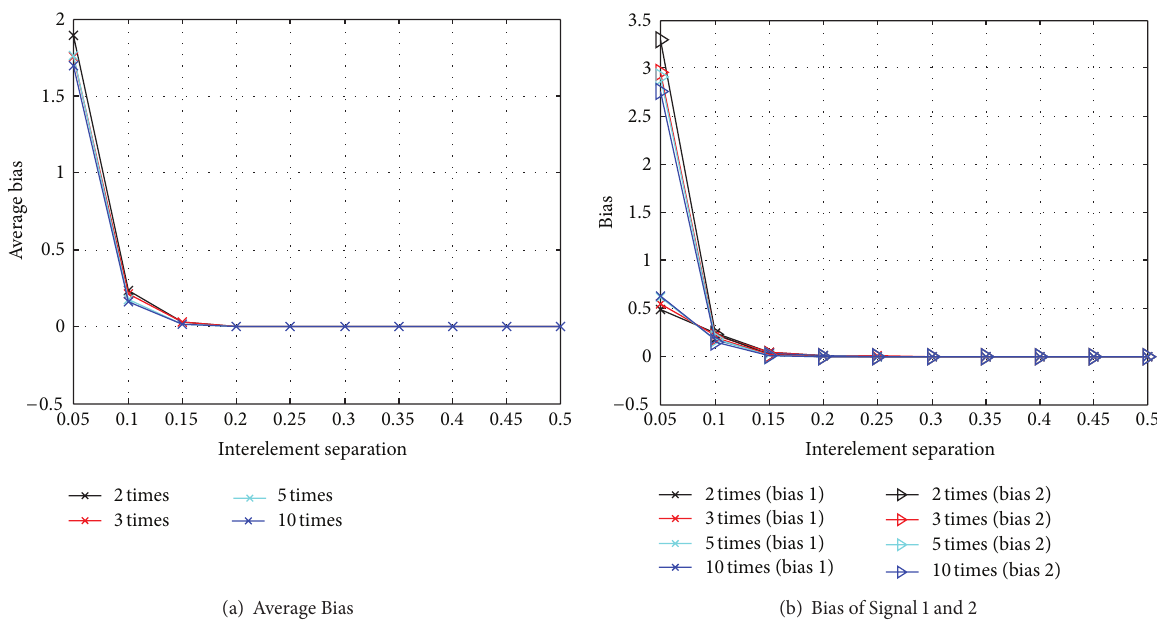
Figure 2: Summary of DOA estimations using MPM for a four-element ULA with interelement separation varying from 0.05𝜆 to 0.5𝜆 . The two incoming signals are from the directions of 𝜙 1 = 5 ∘ (𝐴 1 = 1 , 𝛾 1 = 90 ∘ ) and 𝜙 2 = 6 ∘ (𝐴 2 = 2 , 3 , 5 , and 10 , 𝛾 2 = 180 ∘ ) with an SNR of 5dB. (a) Average biases of the estimated directions; (b) biases of the estimation of signal 1 and signal 2.